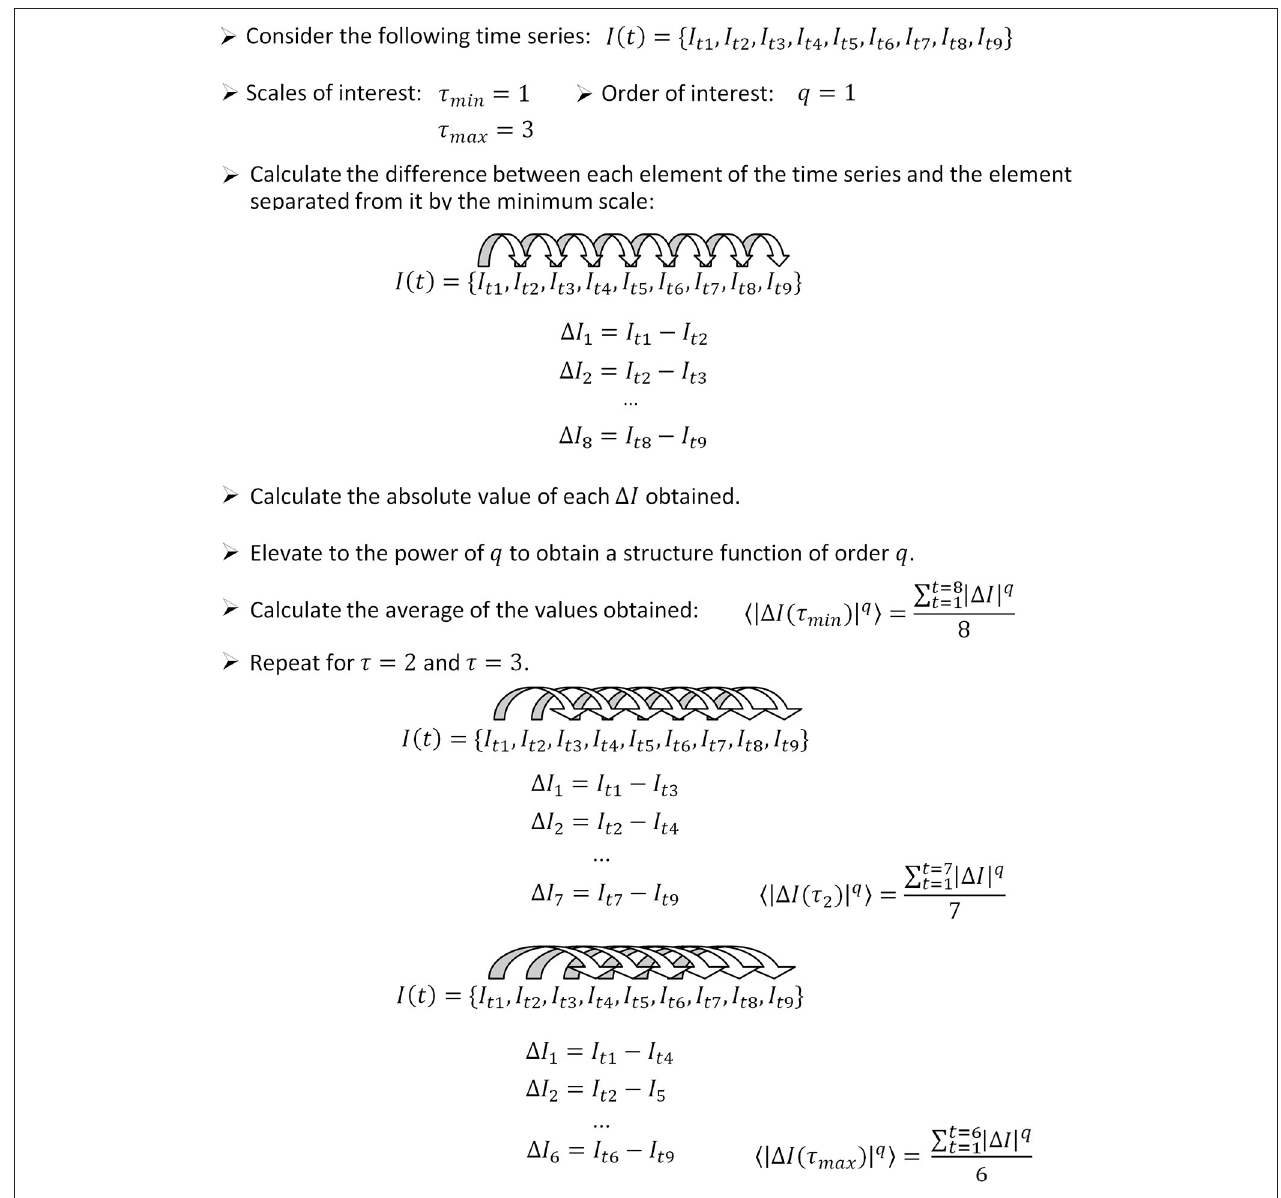
FIGURE 1 | How to apply the algorithm for the calculation of the temporal structure function to a sample time series. In this example, we calculate the structure function of order 1, therefore the power step is not needed. The number of differences computed for each scale (used as the denominator to calculate the average) is equal to the length of the time series minus the scale. We show how to calculate three points of a temporal structure function ( S ( τ 1,2,3 )), corresponding to scales 1–3. Typically, large scale ranges are of interest to characterize short and long term dynamics (for instance S ( τ 1 − 1000